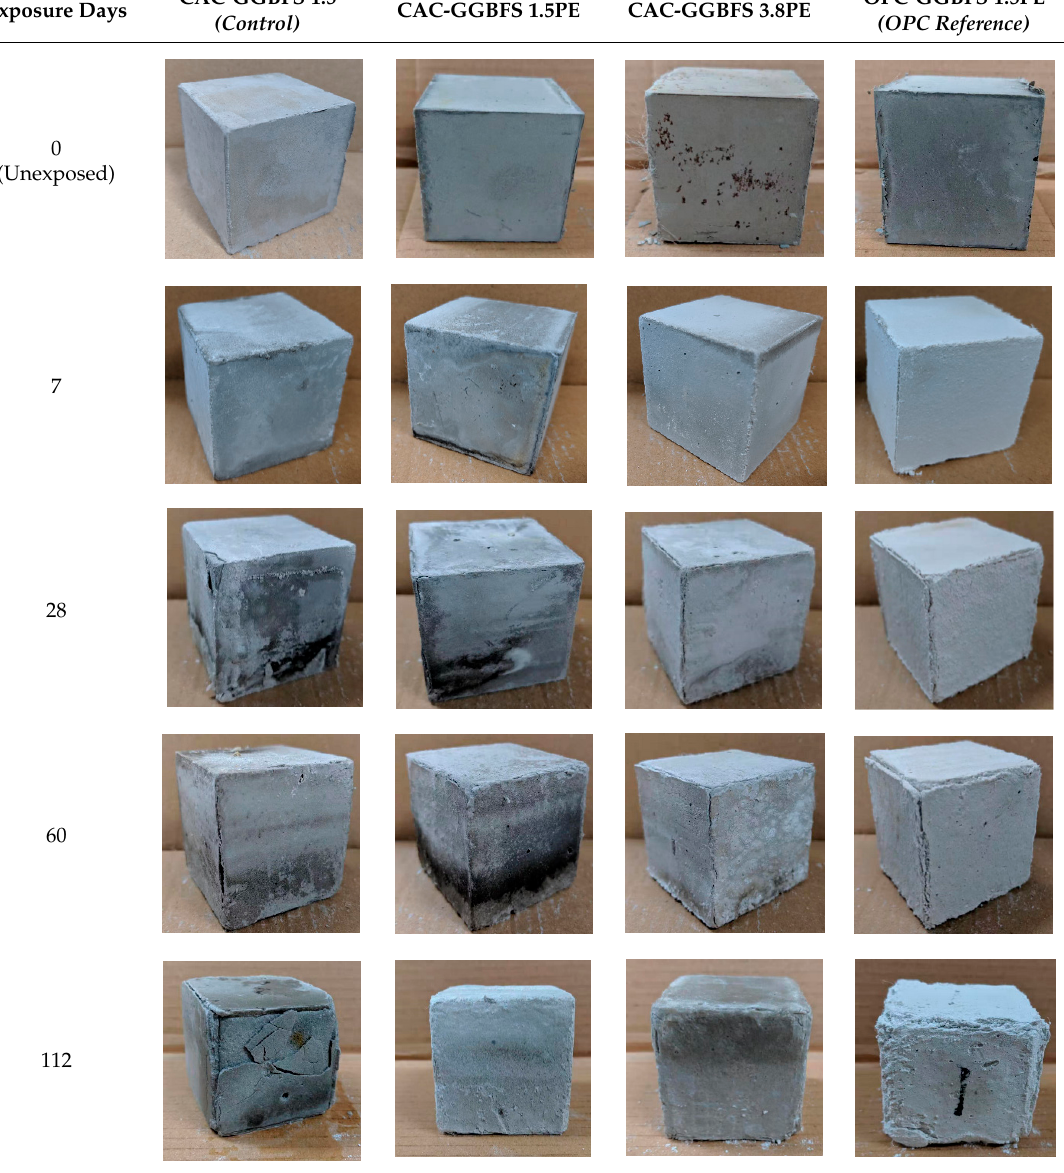
Table 3. Visual observation of samples after different age of acid exposure.